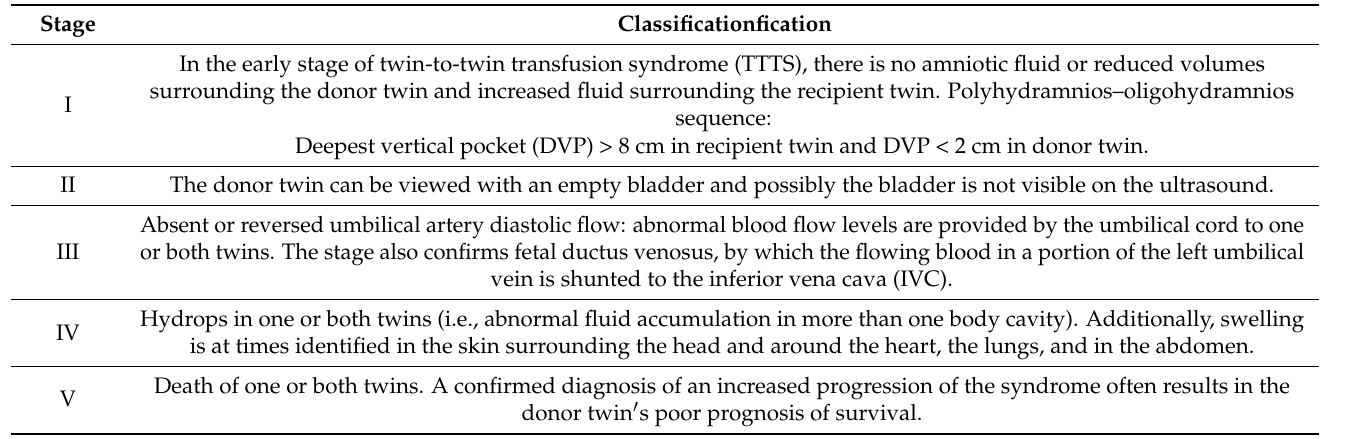
Table 1. Quintero stage